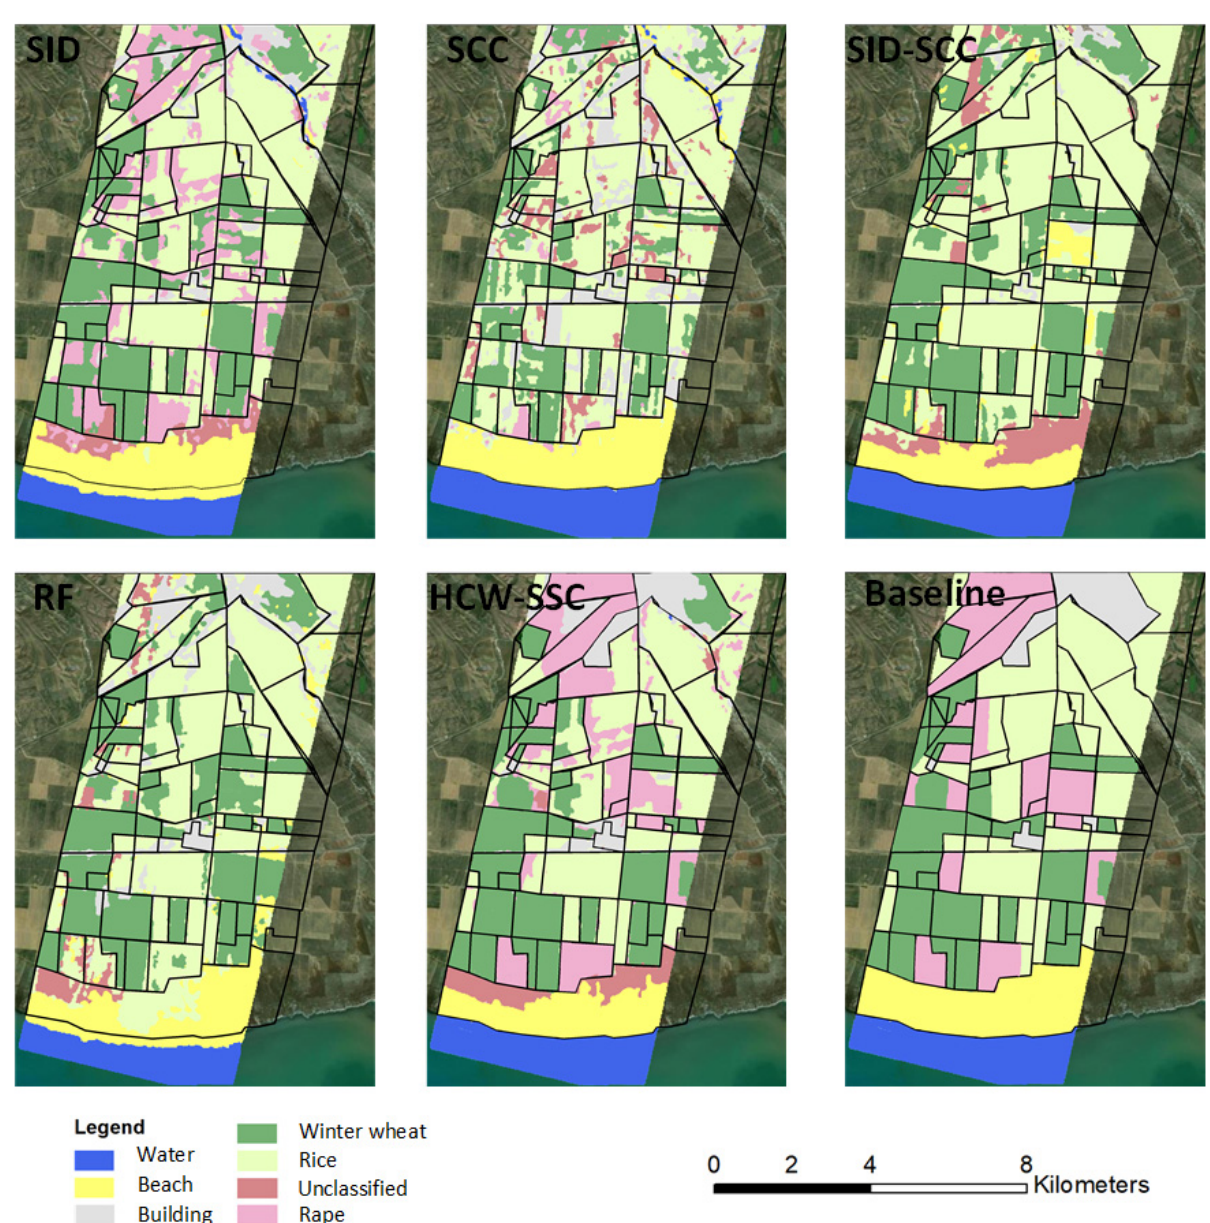
Figure 8. Classification maps of five different classification methods and baseline map (spectral information divergence (SID), spectral correlation coefficient (SCC), spectral information divergence– spectral correlation coefficient (SID-SCC), random forest (RF), and a new hybrid changing-weight classification method with a filter feature selection (HCW-SSC)).